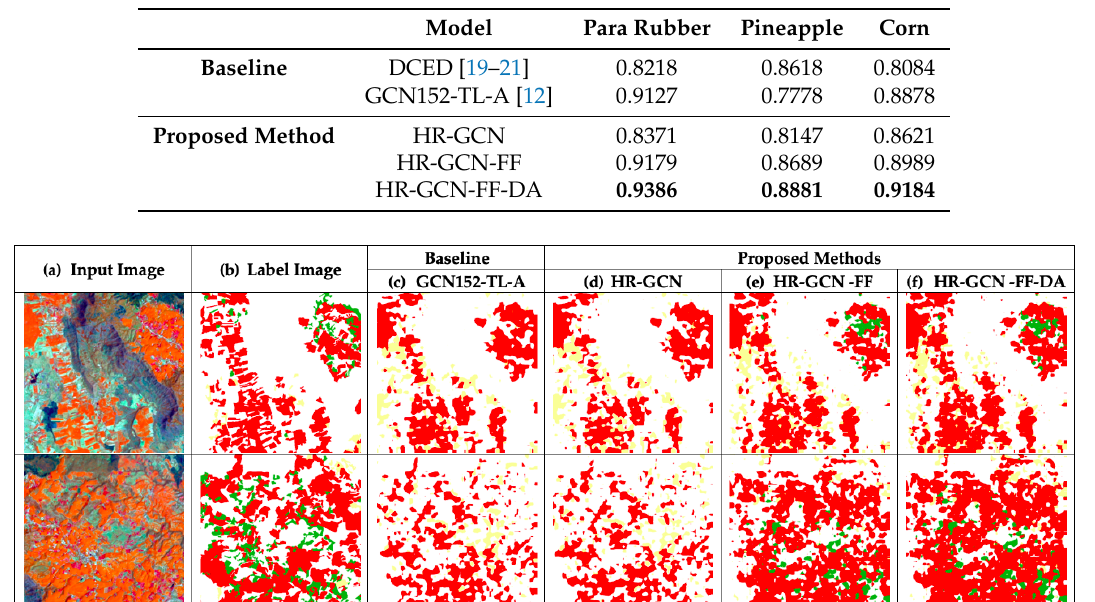
Table 4. Effects on the testing set of the Landsat-8w3c data set among each class with our proposed procedures in terms of AverageAccuracy .